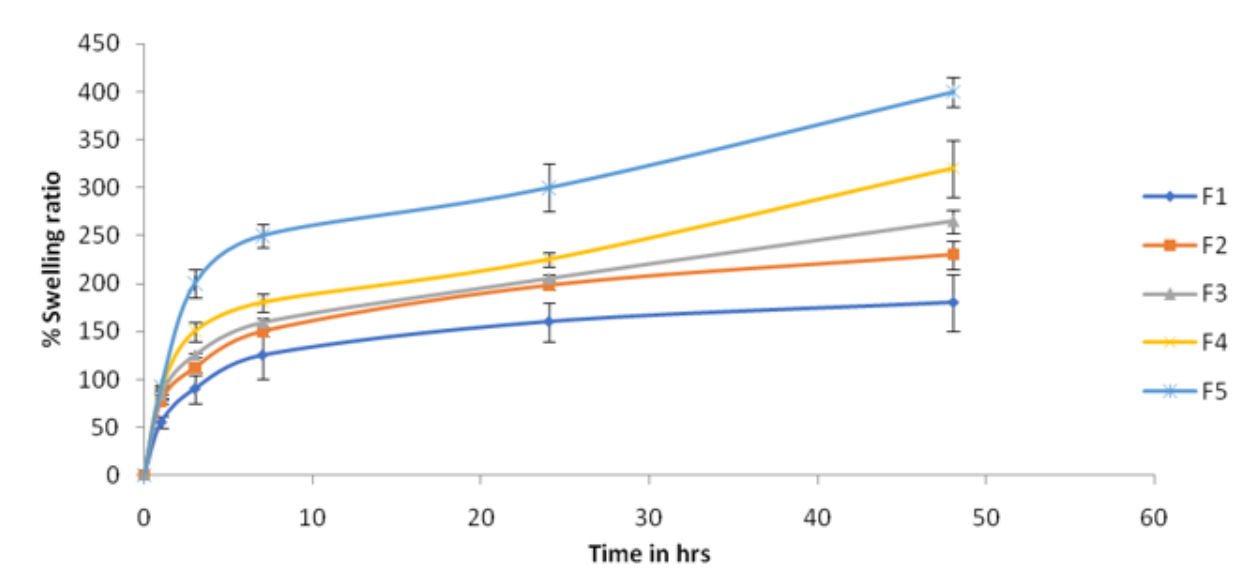
Figure 2. Swelling ratio hydrogel film batches ( n = 3).